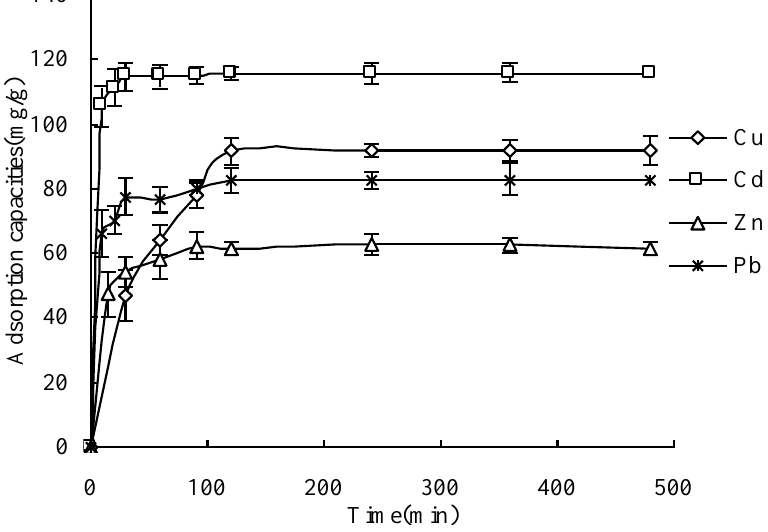
Figure 2. Influence of time on adsorption capacities of CCM for metal ions (initial metal solution concentration = 100 ppm; agitation speed = 180 rpm; temperature = 25 °C; dosage = 1.0 g/L; initial pH =